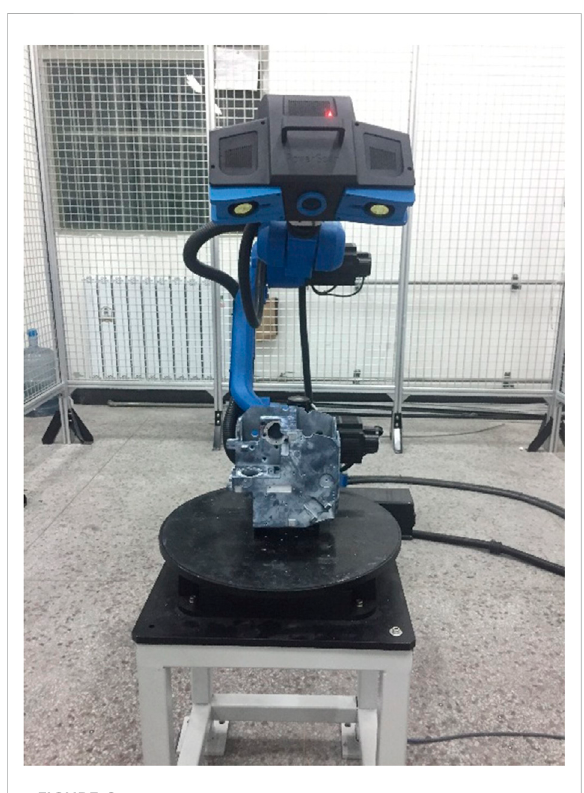
FIGURE 6 Schematic diagram of the placement of